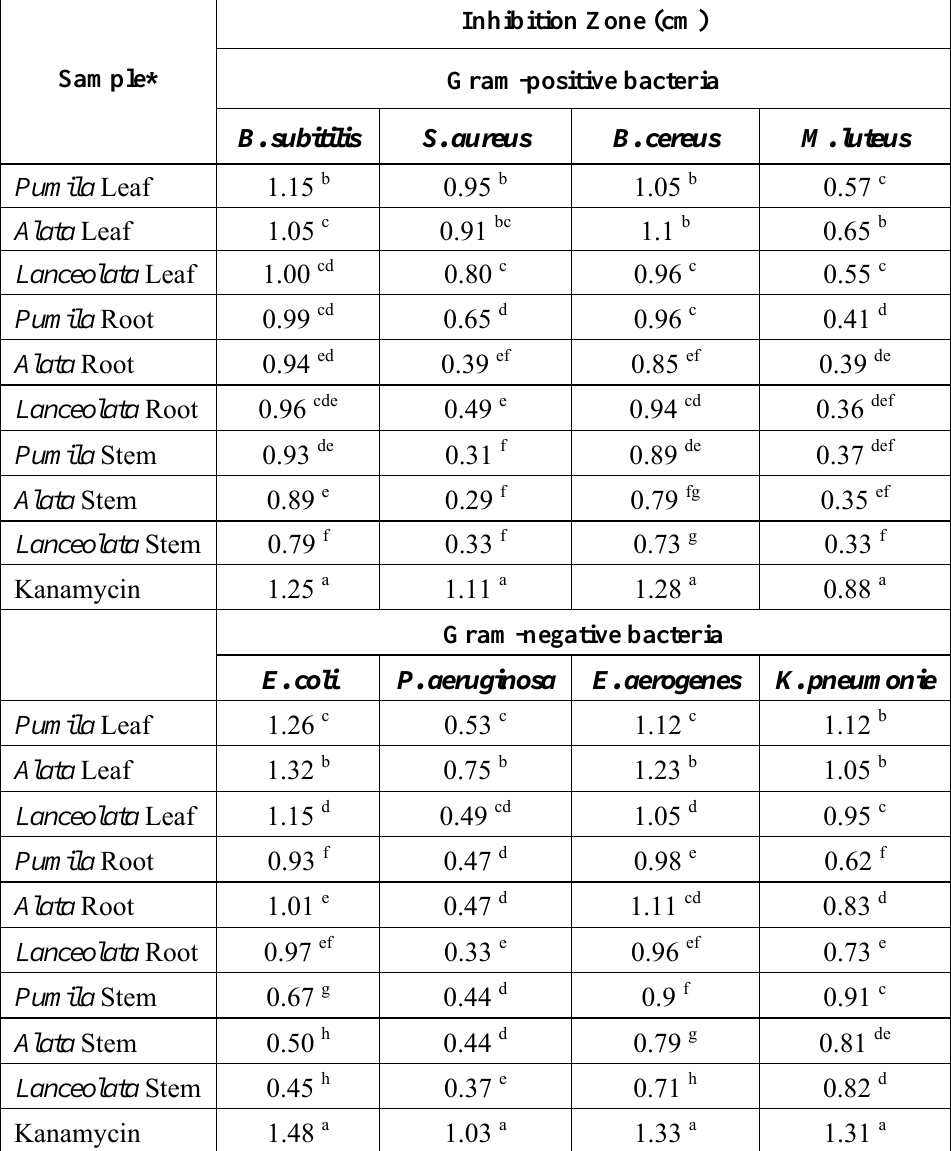
Table 4. Inhibition zones of leaf, stem and root extracts of three varieties of Labisia pumila against pathogenic bacteria at concentration of 300